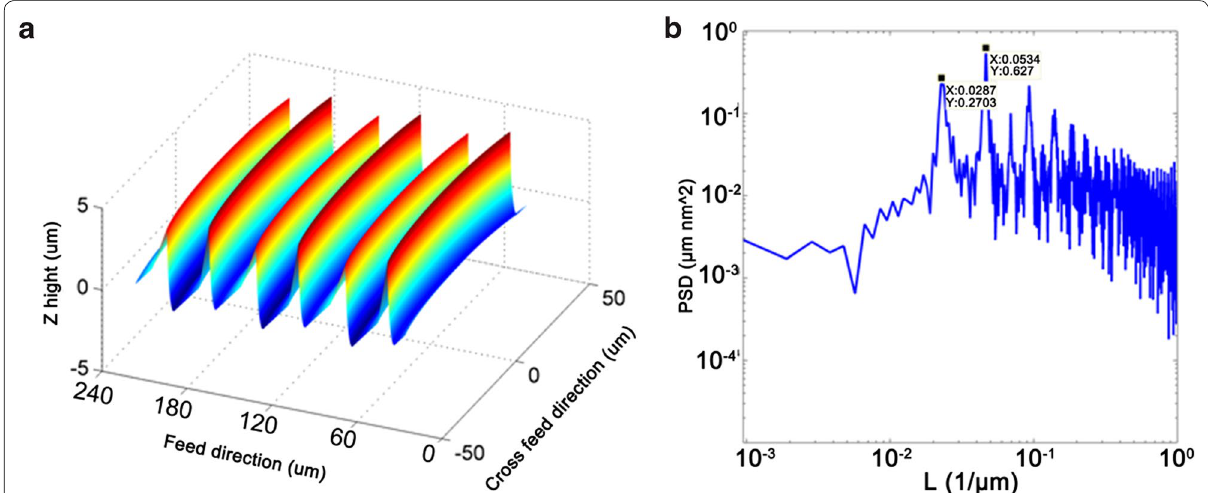
Figure 12(a) shows the surface topography simula- tion results of 35 μm feed per tooth. The PSD analysis of the simulation results as shown in Figure 12(b) indi- cates that the period of the tool marks is determined as 0.0287 μm − 1 (35 μm), which indicates that with the increase of the feed per tooth, the effect of axial runout on the topography can be reduced. Each cutting tooth can be reflected in the final surface topography, there- fore, the tool marks period agree with the feed per